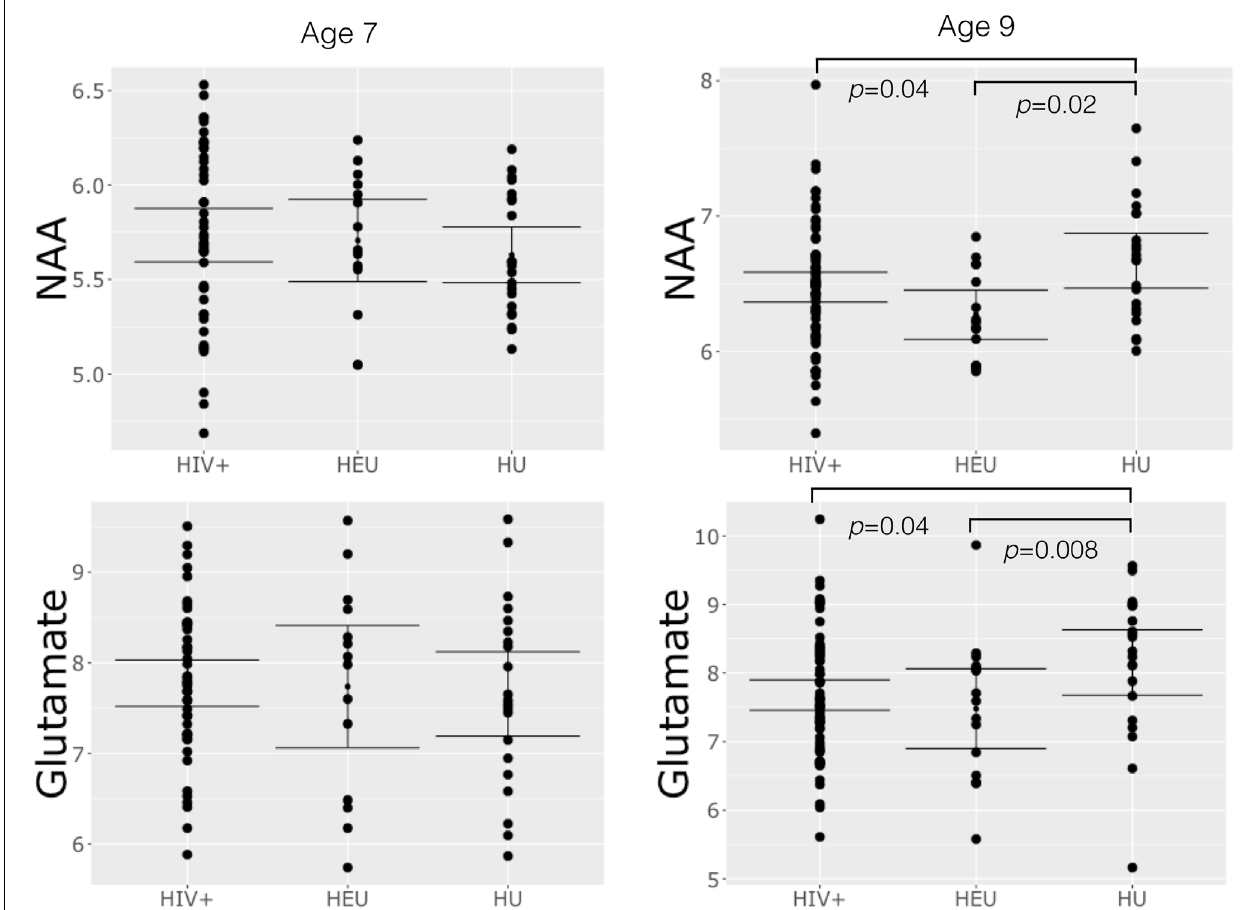
FIGURE 2 | Plots of basal ganglia NAA and glutamate at age 7 and 9 showing mean, 95% confidence intervals and differences in group means significant at p <